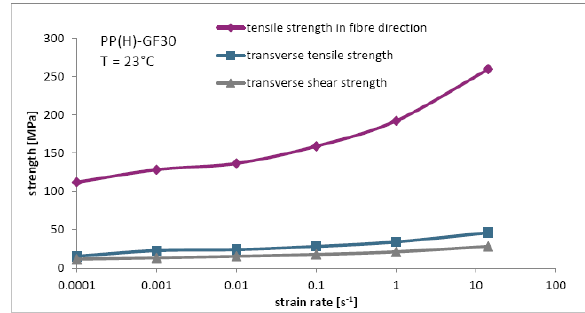
Figure 3. Illustration of strength parameters for different strain rates.